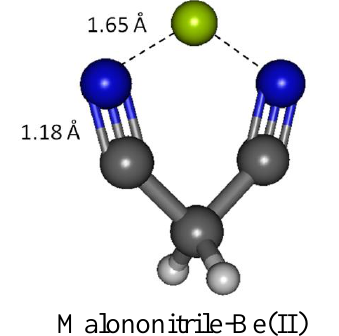
Figure 8. Optimized geometries of malononitrile and its complex with Be(II).